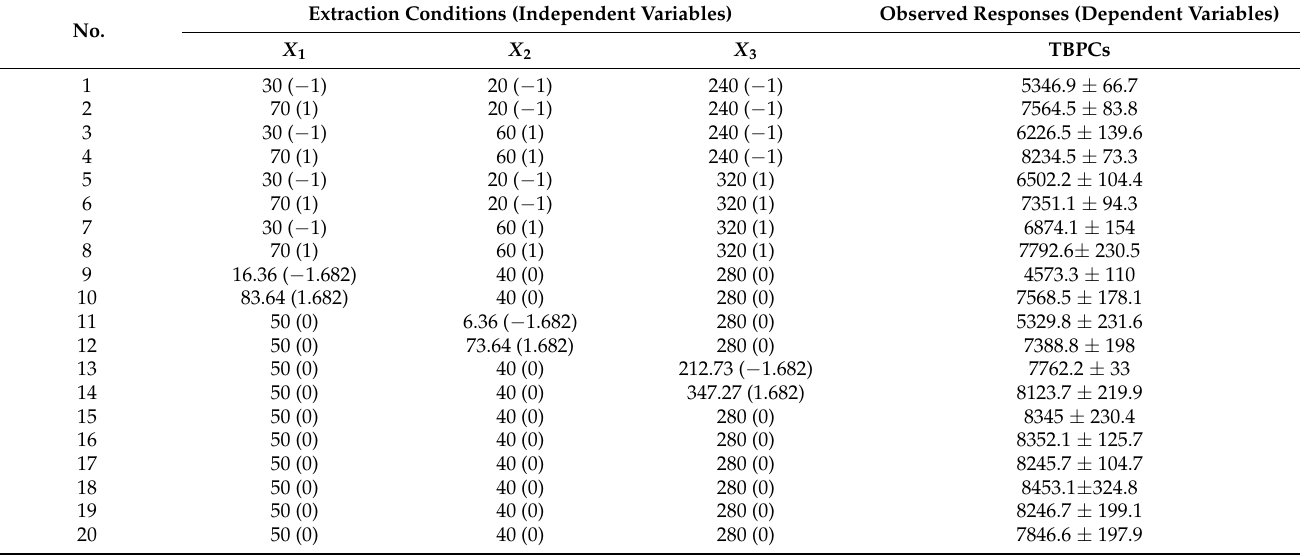
Table 3. The UAE experimental design in coded and uncoded form for the optimization of variables using CCD.